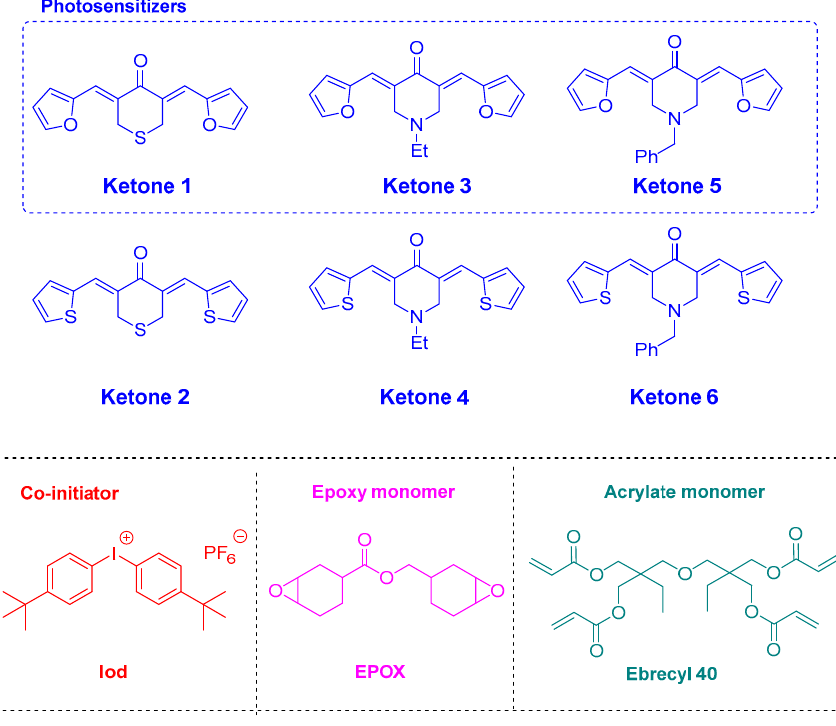
Figure 5. Chemical structures of ketones 1–6, different monomers and additives.